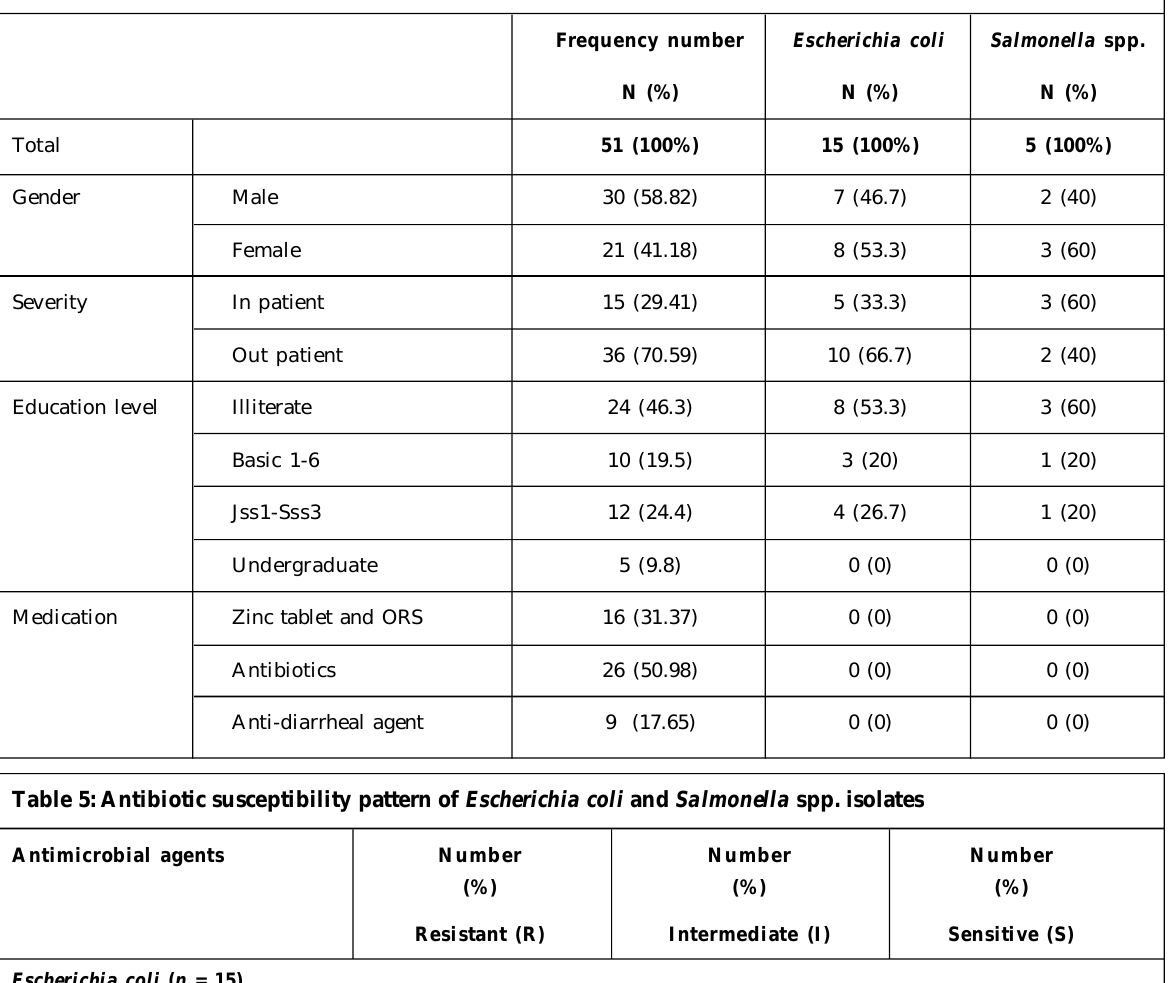
Table 5: Antibiotic susceptibility pattern of Escherichia coli and Salmonella spp. isolates Antimicrobial